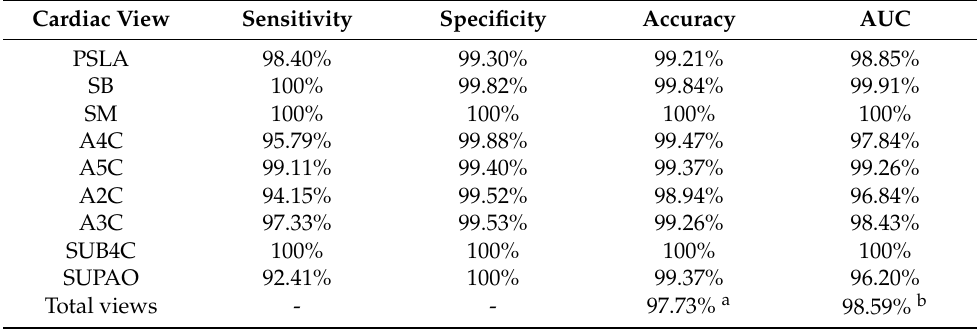
Table 6. Test results of the presented method on Dataset 2.